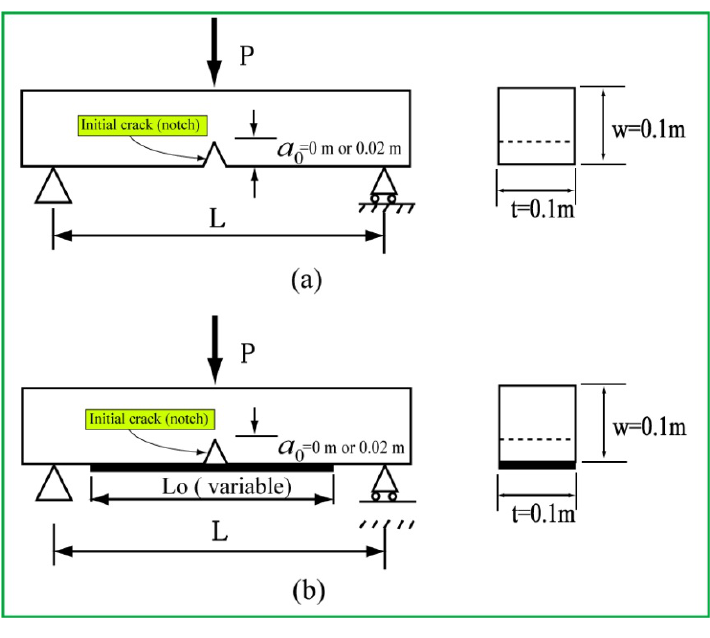
Figure 1. The geometrical configuration for a concrete beam: ( a ) a concrete beam without CFRP; and ( b ) a concrete beam with